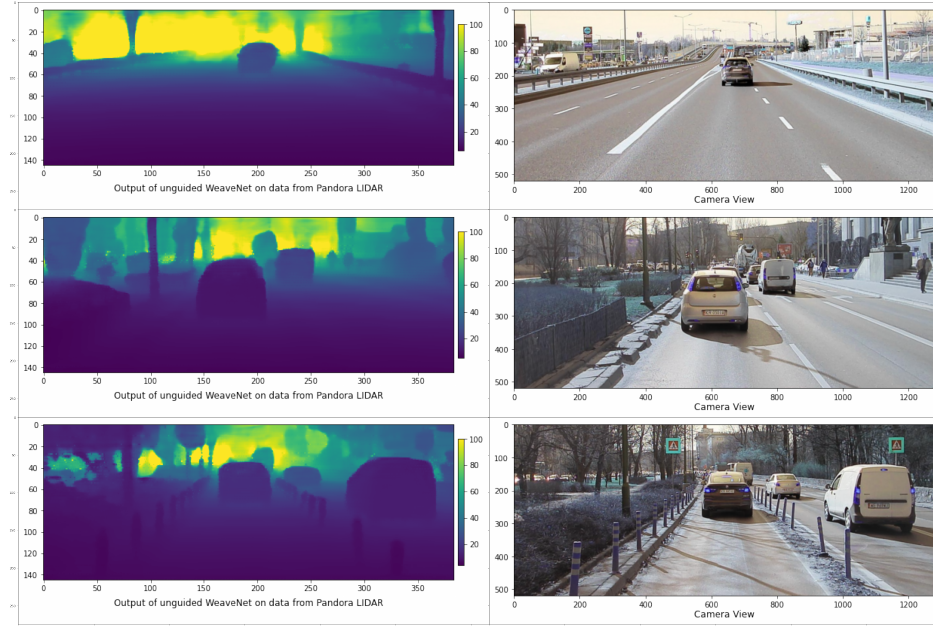
Figure 10. Output of the universal sparsity, unguided WeaveNet operating on the data from Pandora LIDAR ( left ) and corresponding camera images ( right